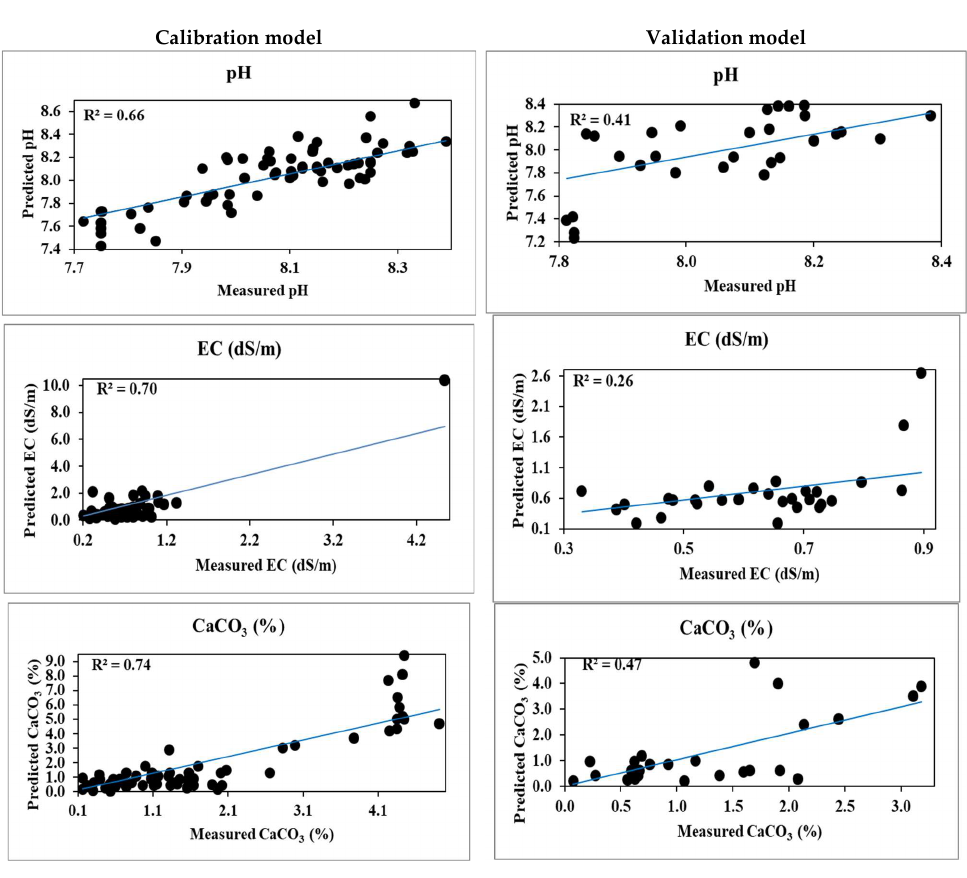
Figure 7. SVR calibration and validation of soil parameters.